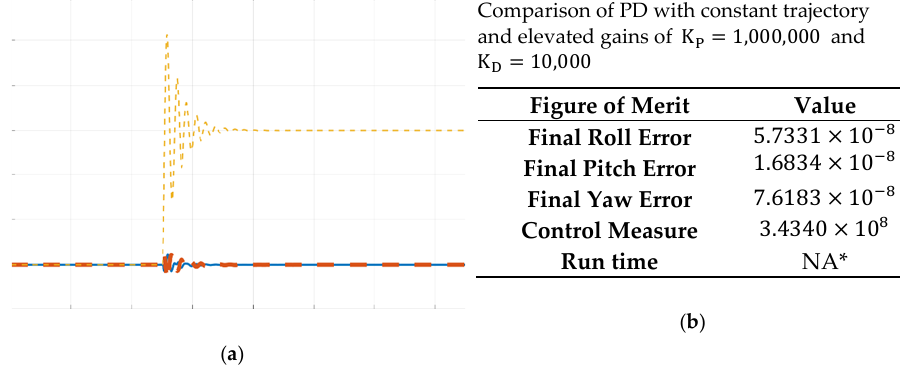
Figure 4. System response of PD control with constant trajectory. ( a ) Plot of Euler angles during the maneuver. Roll is solid blue, pitch is thick dashed red, yaw is thin dashed yellow ( b ) Characteristics of the response. * Note, this run time was found to be much lower due to differences in available processing power and when compared to re-simulations of some of the above methods, found to be comparable.